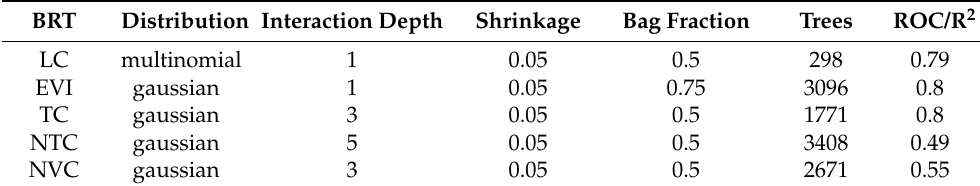
Table 3. Summary of BRT hyper parameters and performance.